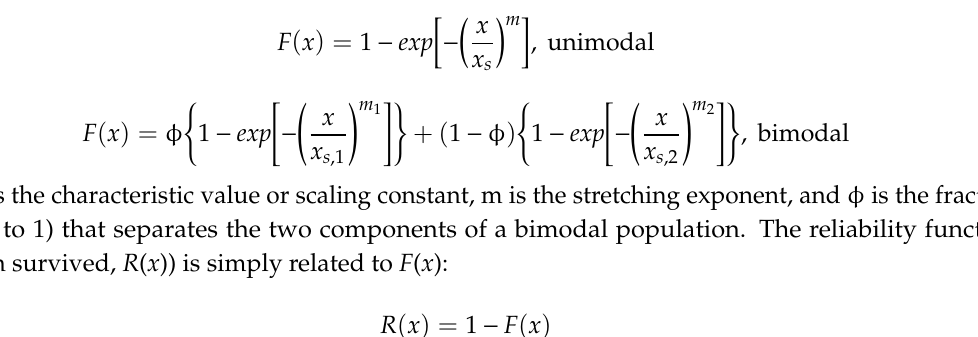
Figure 11. Approximation for strain energy density at break ( W b ≈ ½ σ b ε b ) versus actual W b for the four compounds. The solid line shows equivalence of the two quantities.